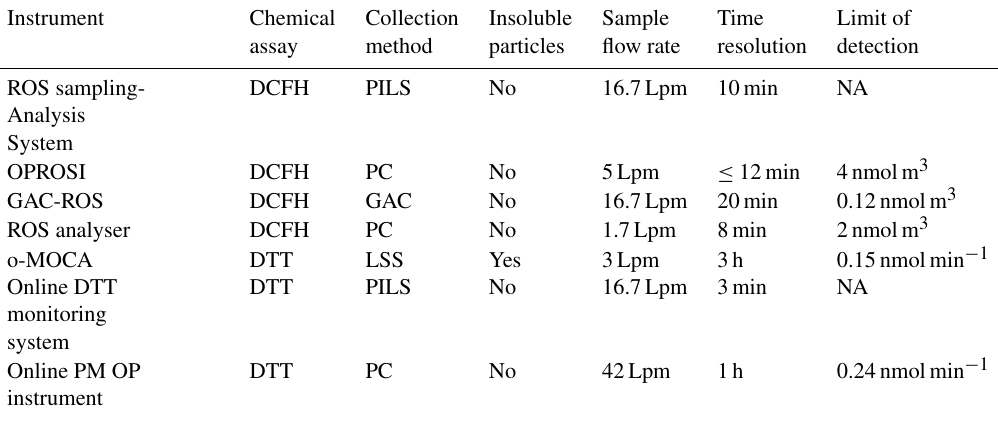
Table 1. List of online ROS instruments and their key characteristics, including a ROS sampling–analysis system (Venkatachari and Hopke, 2008; Wang et al., 2011), OPROSI (Fuller et al., 2014; Wragg et al., 2016), GAC-ROS (Huang et al., 2016a), ROS analyser (Zhou et al., 2018), o-MOCA (Eiguren-Fernandez et al., 2017), online DTT monitoring system (Koehler et al., 2014; Sameenoi et al., 2012), and online PM OP instrument (Puthussery et al., 2018). Limit of detection (LOD) for DCFH systems is given as equivalent H 2 O 2 concentrations per cubic metre of air. O-MOCA LOD is given as DTT consumption per minute. Instrument Chemical Collection